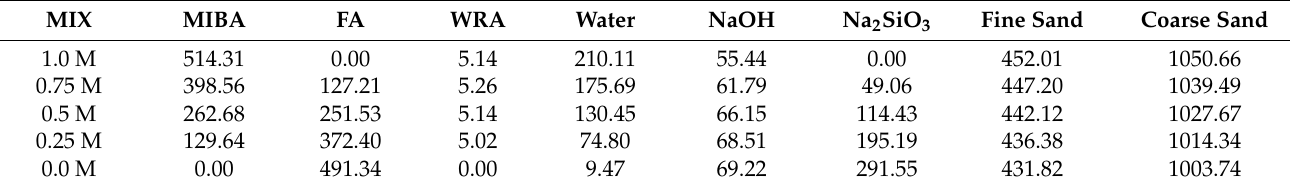
Table 1. Composition of alkali-activated mortars with OAA (g/dm 3 ).